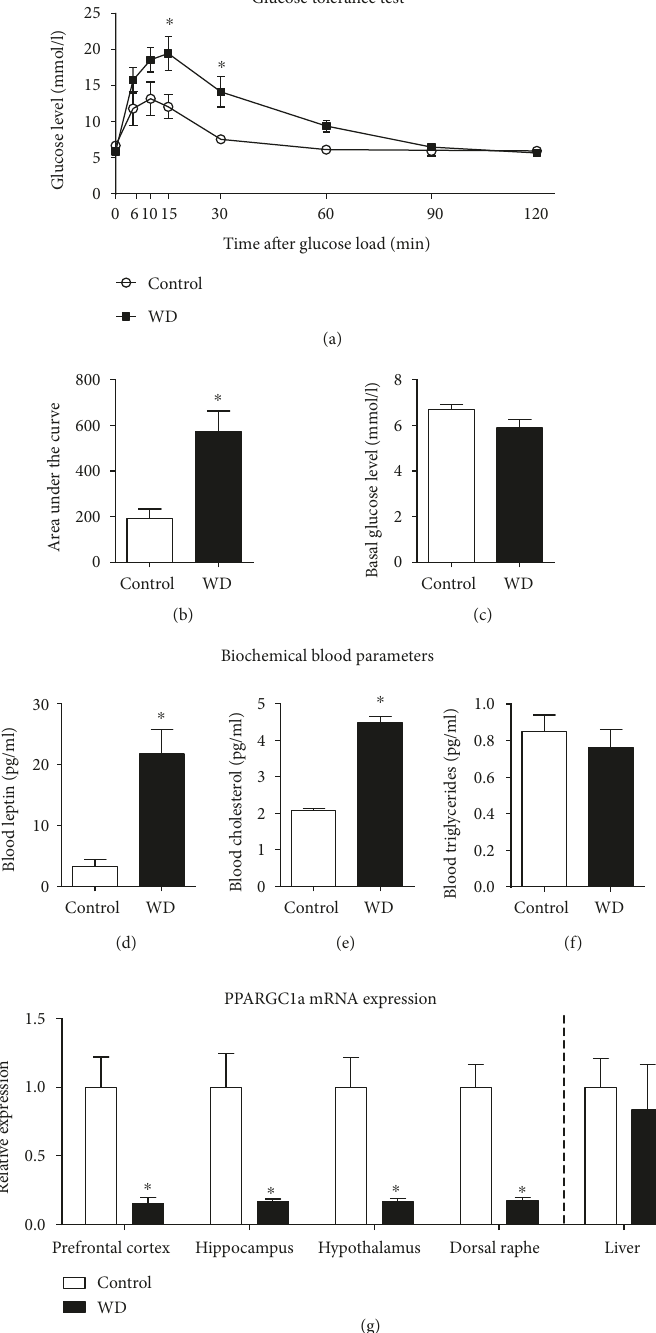
Figure 6: E ff ects of high-cholesterol diet exposure on glucose tolerance, biochemical blood parameters, and PPARGC1a gene expression. (a) In comparison to that in the control, there was an increase in blood glucose level at 15 and 30min after glucose load in the glucose tolerance test ( ∗ p < 0 05 versus that in the control group, 2-way ANOVA and Bonferroni post hoc test). (b) There was a signi fi cant increase in the area under curve in glucose concentration in dietary-challenged mice in comparison to controls ( ∗ p < 0 05 versus control group, t -test). (c) There was no signi fi cant di ff erence in basal glucose levels between mice housed on the standard and high-cholesterol diets. Mice housed on the high- cholesterol diet, as compared to the control group, showed signi fi cantly increased (d) blood leptin levels, (e) blood cholesterol levels ( ∗ p < 0 05 versus that in the control group, t -test), and (f) unaltered blood level of triglycerides ( p > 0 05 versus that in the control group, t -test). (f) In comparison to control mice, animals fed with the cholesterol-enriched diet had signi fi cantly decreased PPARGC1a mRNA in all brain areas ( ∗ p < 0 05 versus that in the control group, 2-way ANOVA and Bonferroni post hoc test) but not in the liver ( p > 0 05 versus that in the control group, 2-way ANOVA and Bonferroni post hoc test). Control — standard diet, WD — high-cholesterol diet. Data are shown as mean ±